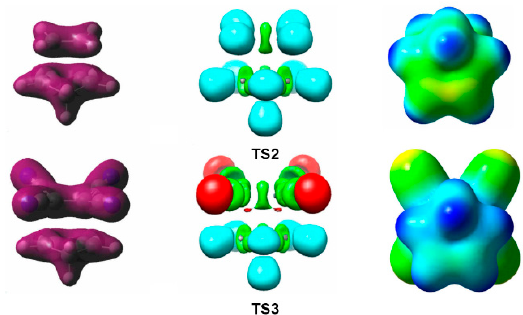
Figure 5. MPWB1K/6-31G(d) maps of the total electron density and ELF valence basins, and MEP for the TSs involved in the non-polar DA reaction between Cp 6 and ethylene 2 , TS2 , and in the polar DA reaction between Cp 6 and TCE 9 , TS3 . Isovalues of the map electron density are 0.08 and ELF valence basins were represented at an isosurface value of 0.8.